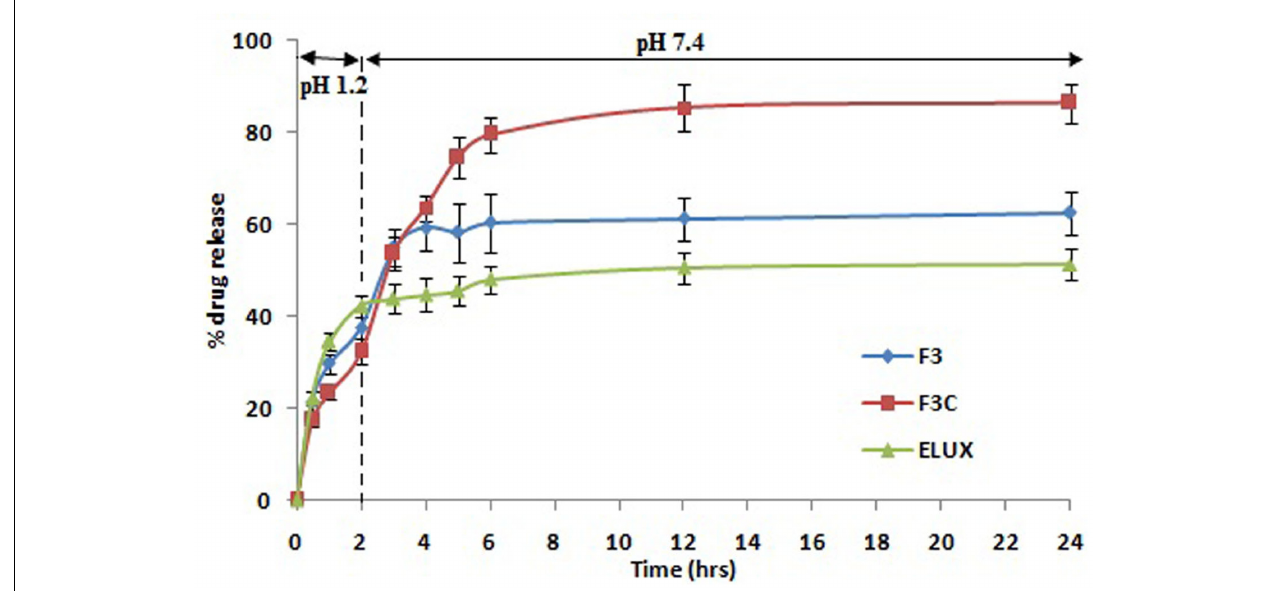
FIGURE 3 | Comparative in vitro release profile.